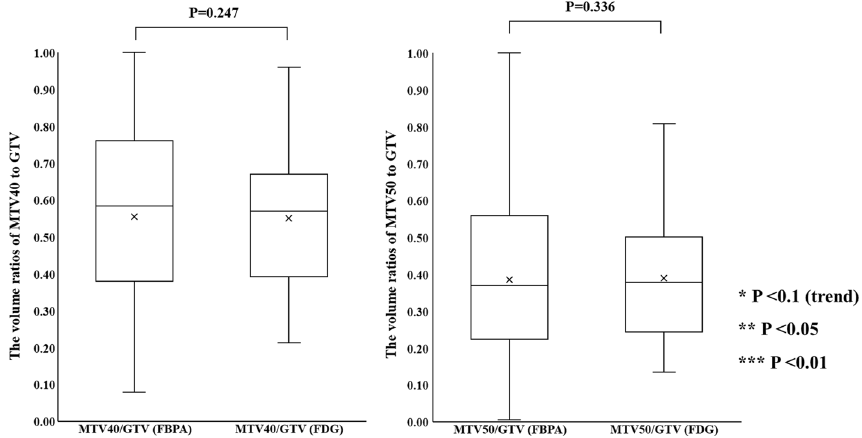
Fig. 12 The similarity indices, including Dice similarity coefficient, Jaccard coefficient, and mean distance to agreement, of MTV40 and MTV50 between 18 F-FDG and 18 F-BPA PET for all